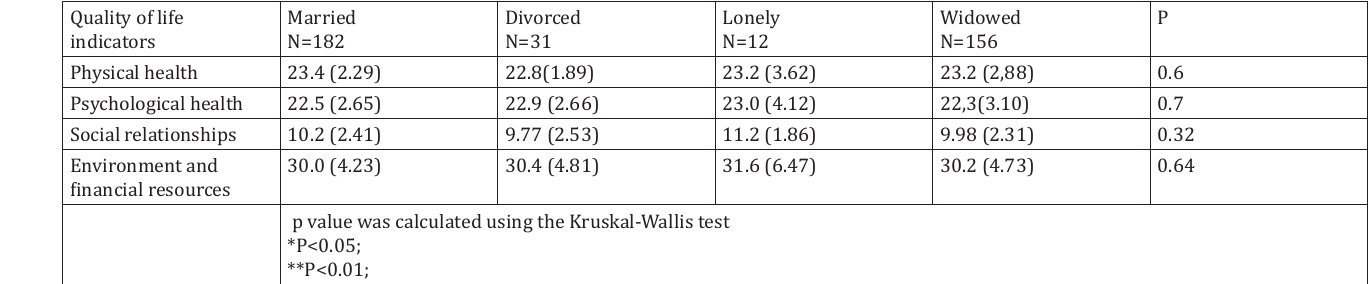
Relationship between marital status and quality of